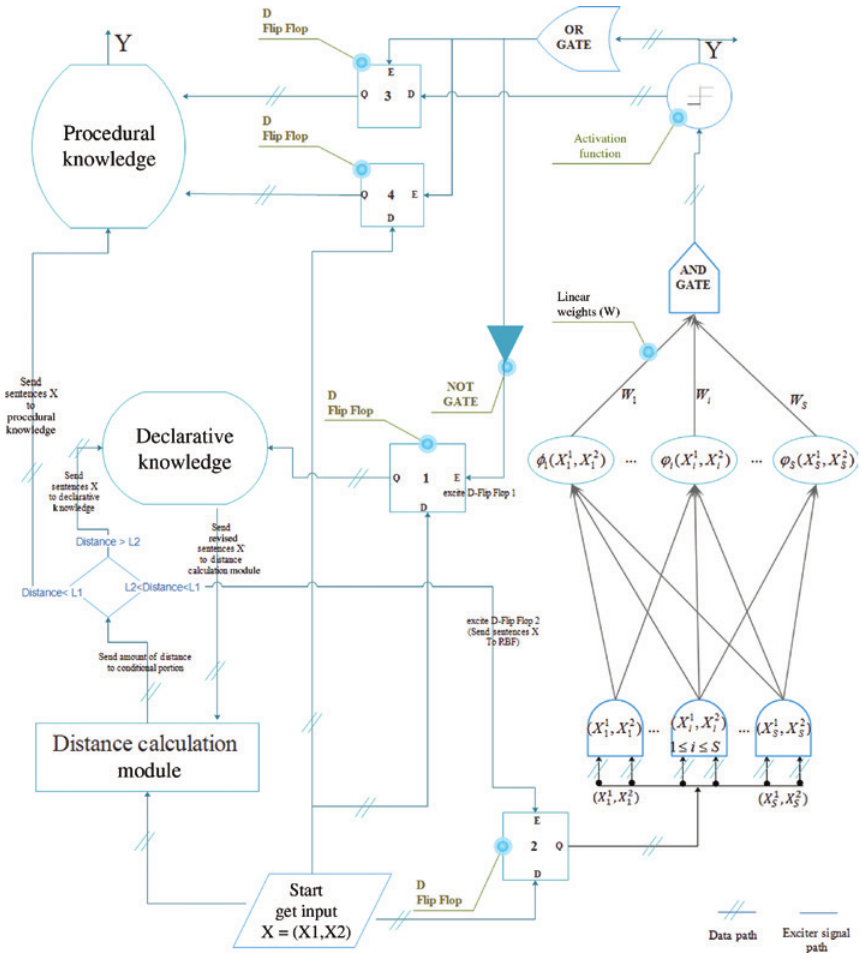
Figure 3: Hybrid ACT/R-RBF Architecture